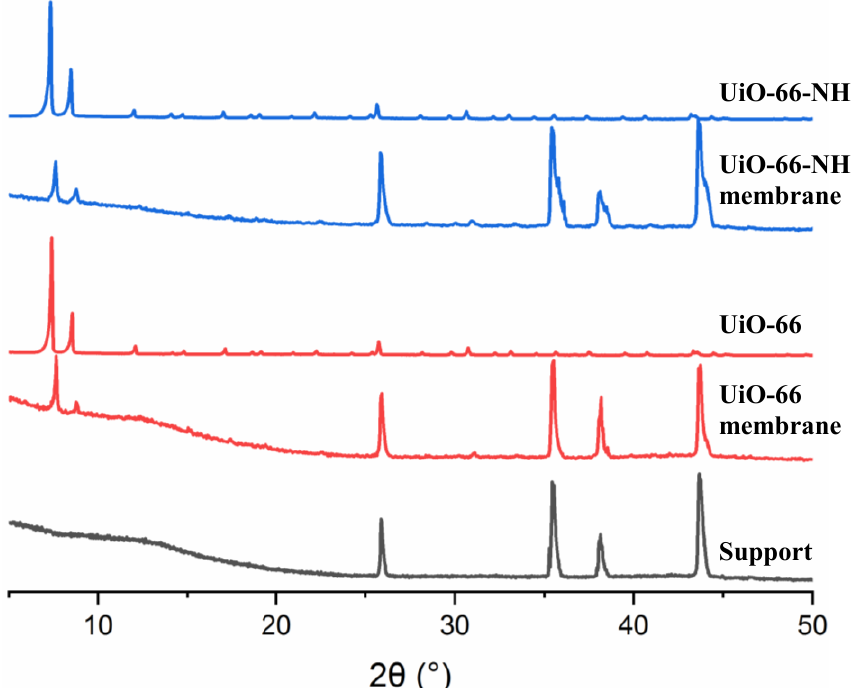
Figure 3. Experimental PXRD patterns of α -alumina membrane support, UiO-66 MOF-based membrane and polycrystalline UiO-66, UiO-66-NH 2 MOF-based membrane and polycrystalline UiO-66-NH 2 .